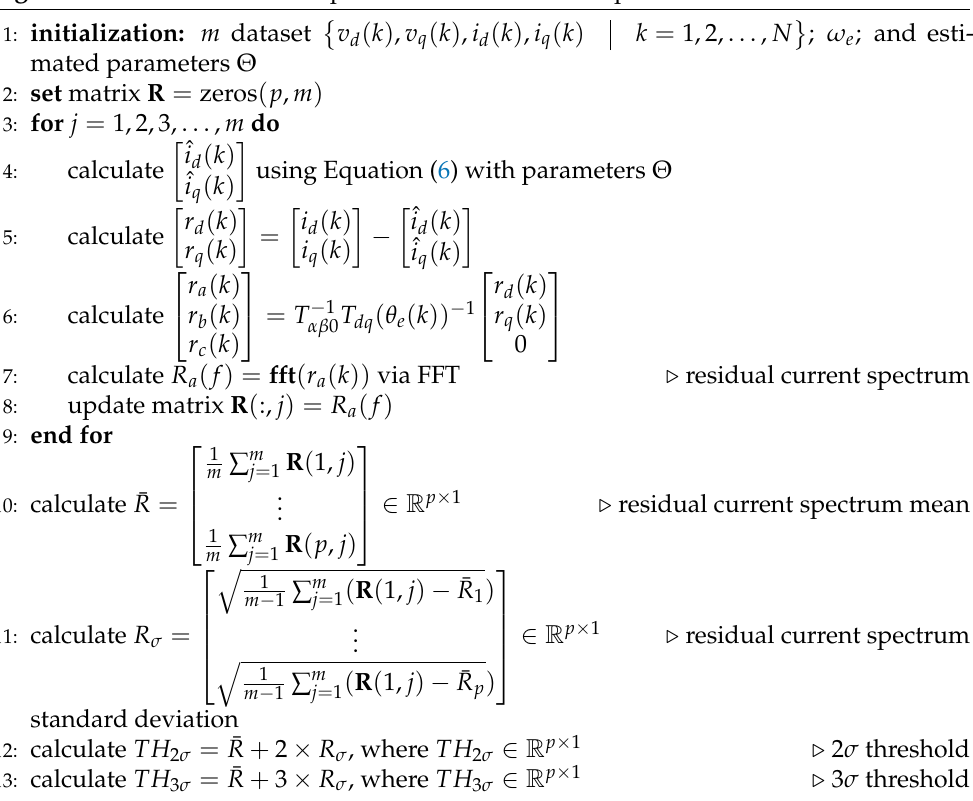
Algorithm 3 Residual current spectrum threshold